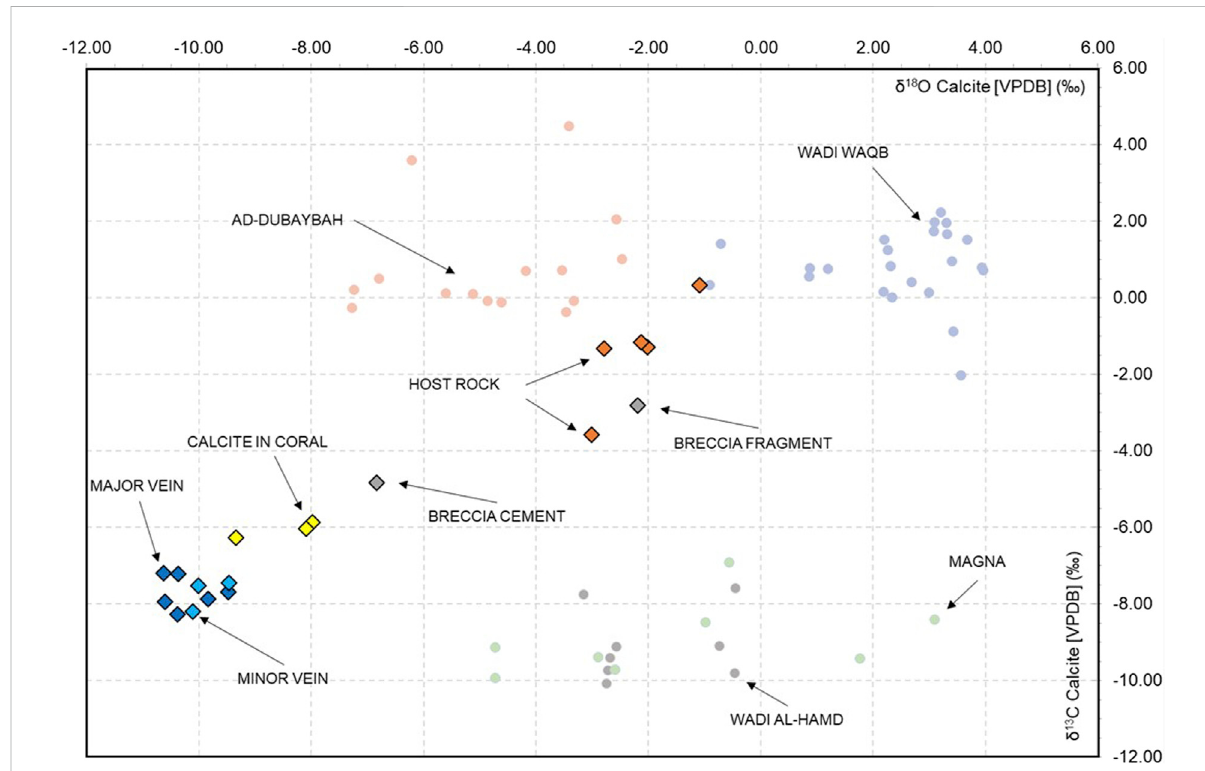
FIGURE 4 Graph plot between δ 13 C VPDB and δ 18 O VPDB of the study area, with the background data from the previous study of Cenozoic carbonate in the Eastern Red